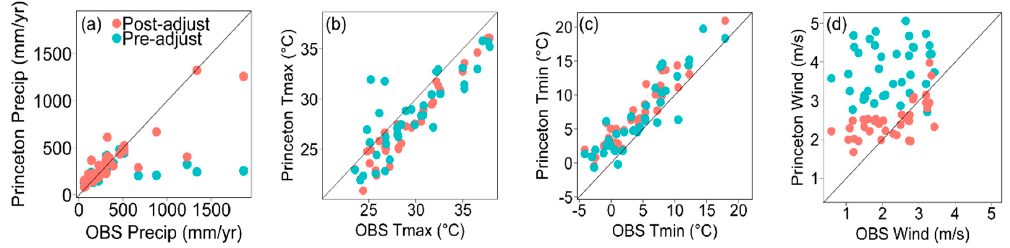
Figure 8. Validation of the adjusted Princeton ( a ) average annual precipitation, ( b ) average monthly maximum and ( c ) minimum temperatures, and ( d ) wind speed against observations. The x -axis represents average annual observed values, and the y -axis represents average annual adjusted values at each of the 37 stations in 1958–1987.